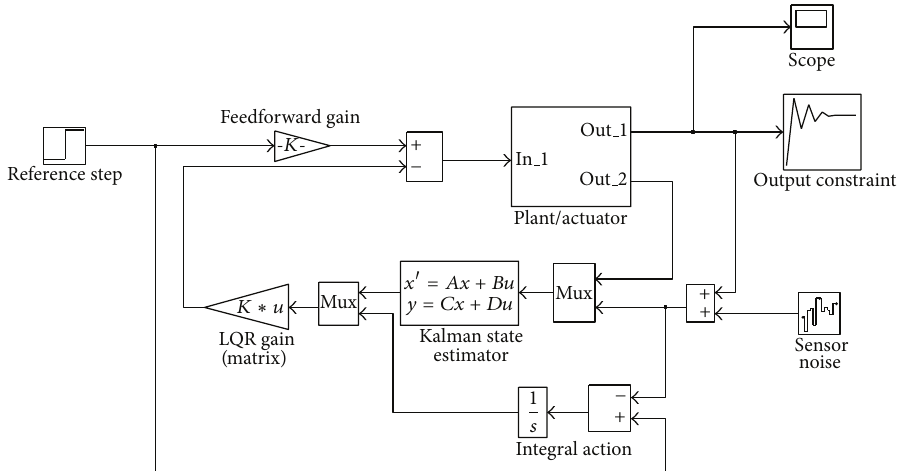
Figure 8: Simulation diagram for roll model.